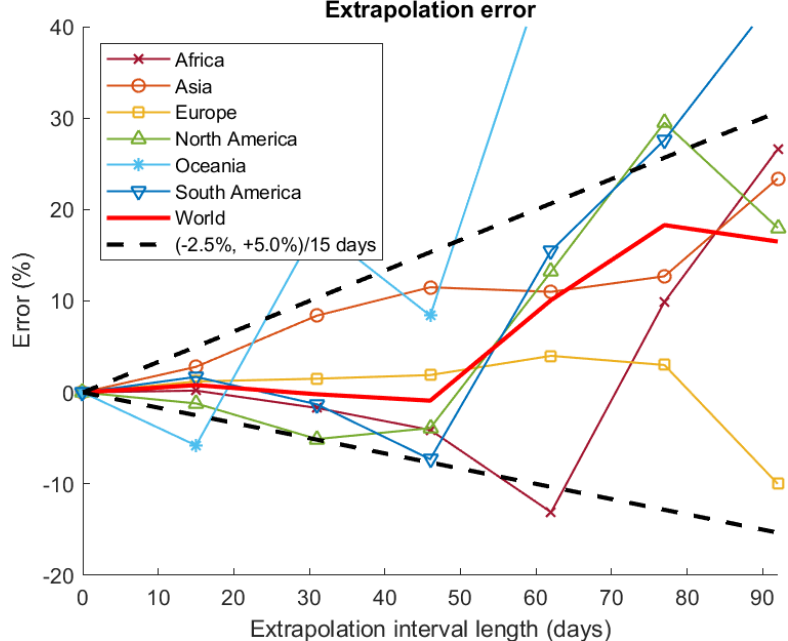
Figure 3. Extrapolation error vs. extrapolation interval length.